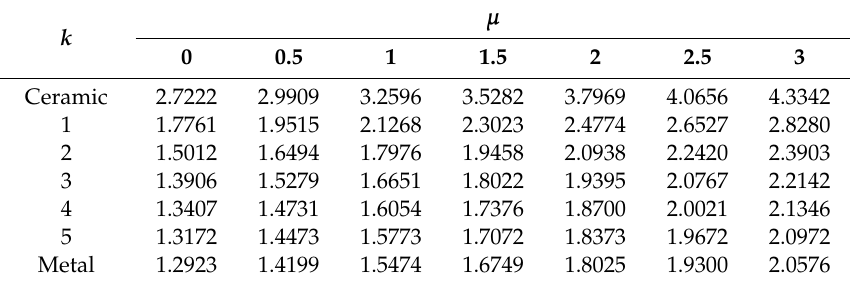
Table 3. The non-dimensional deflection w in a square FG nano-scale plate at a / h = 10. k